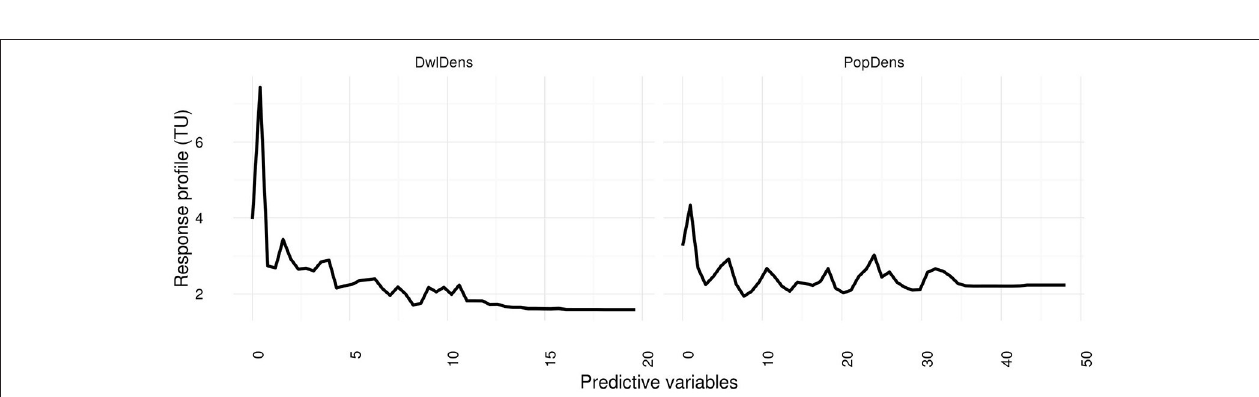
FIGURE 4 | Modeled partial dependence of all organic contaminants (TU total) insecticide and personal care products (PCP) in toxic units on important predictor variables. Marginal response is shaded in proportion to the change in MSE in the relevant model, hence darker shading indicates more important variables.